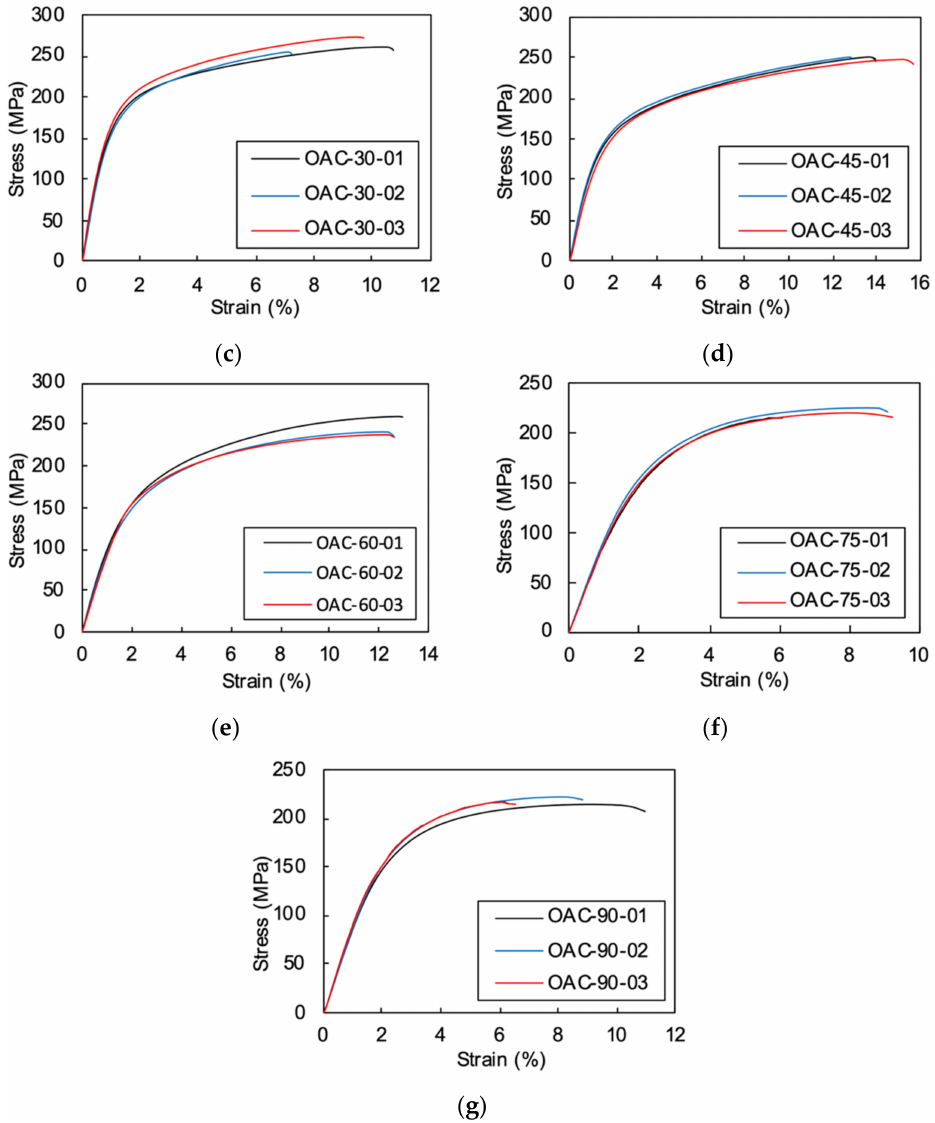
Figure 5. The stress-strain curves of the off-axis specimens under compression: ( a ) 0 ◦ axial com- pression; ( b ) 15 ◦ off-axis compression; ( c ) 30 ◦ off-axis compression; ( d ) 45 ◦ off-axis compression; ( e ) 60 ◦ off-axis compression; ( f ) 75 ◦ off-axis compression; ( g ) 90 ◦ transverse